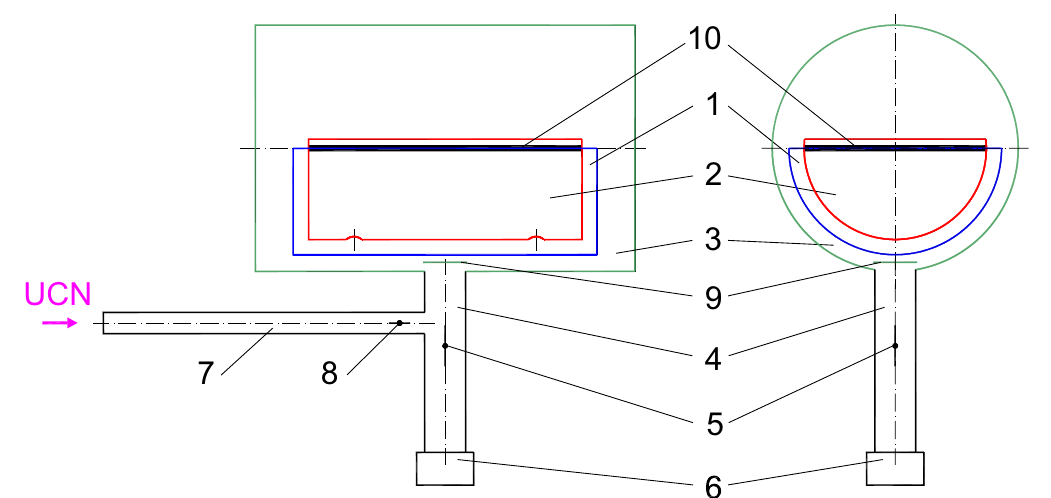
Figure 1. Scheme of the experimental setup. (1) UCN trap; (2) insert; (3) internal vacuum volume at liquid nitrogen temperature; (4) neutron guide for UCN filling and release; (5) shutter of neutron guide for UCN release; (6) UCN detector; (7) input neutron guide; (8) shutter of input neutron guide; (9) thermal shield; (10) titanium absorber attached to